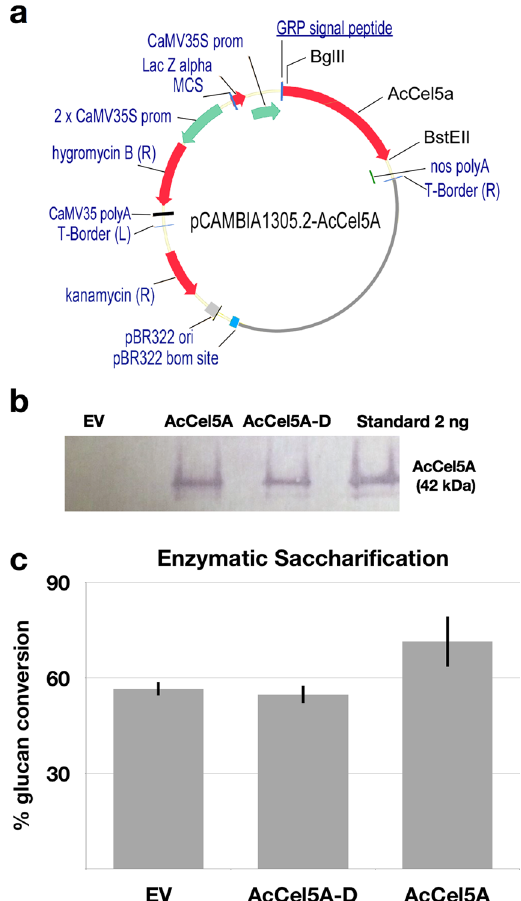
Figure 2. Acidothermus cellulolyticus endocellulase AcCel5A expression construct, AcCel5A Western blot, and enzymatic saccharification. ( a ) The backbone vector pCAMBIA1305.2 (www.cambia.org) has a glycine-rich protein (GRP) signal peptide for extracellular targeting. The catalytically active AcCel5A gene (see supplemental material 1) or AcCel5A catalytic dead gene (AcCel5A-D) replaced the catalase intron-GusPlus gene cassette and the terminator was nopaline synthase (nos) polyA. See Materials and Methods for details. ( b ) Western blot of wild-type empty vector control (EV), AcCel5A and AcCel5A catalytically inactive (AcCel5A-D) transgenic plant lines showing the presence or absence of the AcCel5A protein in plant stem tissue, and a standard of purified AcCel5A. ( c ) Enzymatic saccharification. AcCel5A expression in plant cell walls increases the % glucan conversion by approximately 25% over control levels. The AcCel5A-D data is from line 37-4-a and the AcCel5A data is from line